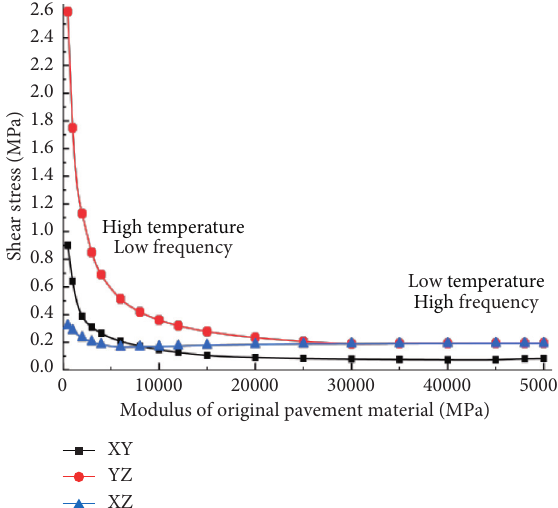
Figure 27: The effect of original pavement material modulus on shear stress of leveling layer.